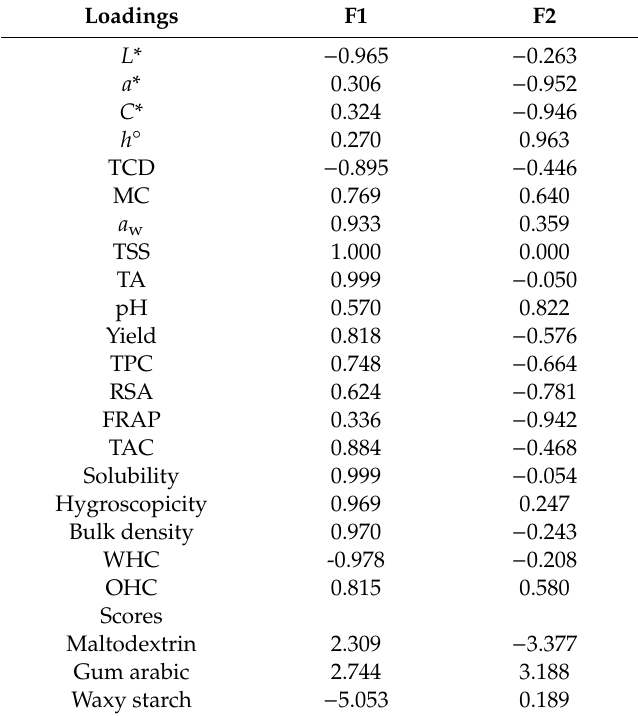
Table 5. Factor loadings, eigenvalue, cumulative variance (%) and score for the first two principal (F1–F2) components based on di ff erent carrier